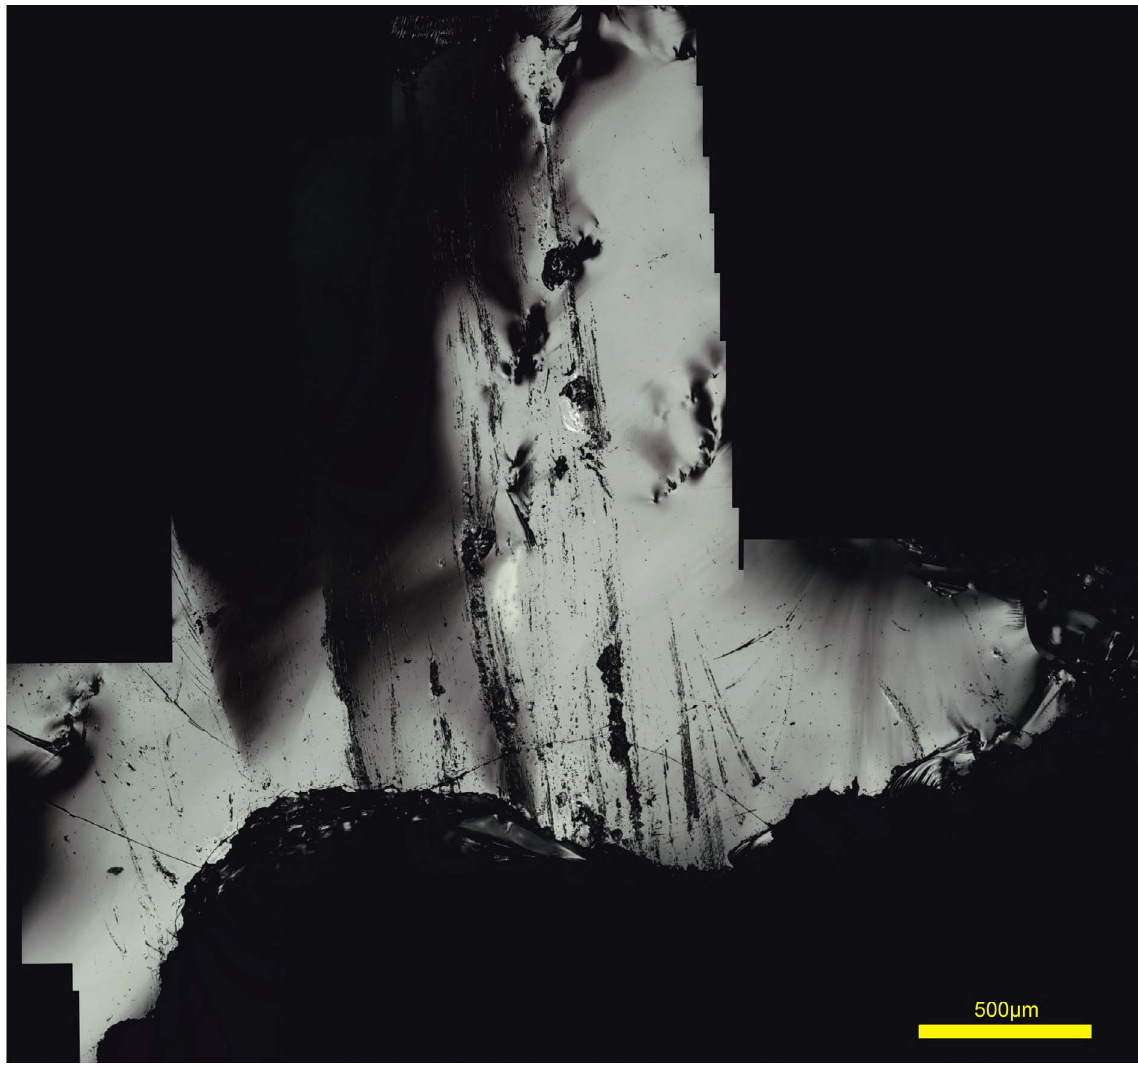
Figure 7. Gigapixel-like image (Gigapixel 2 in Figure 5) of the proximal area in which striations appear associated to percussion marks. Note the retouched area and a non-detached removal (incipient fracture) as well as associated radial fractures. In the gigapixel image (Fernández-Marchena 2017b) some partial hertzian cracks can be observed on the percussion